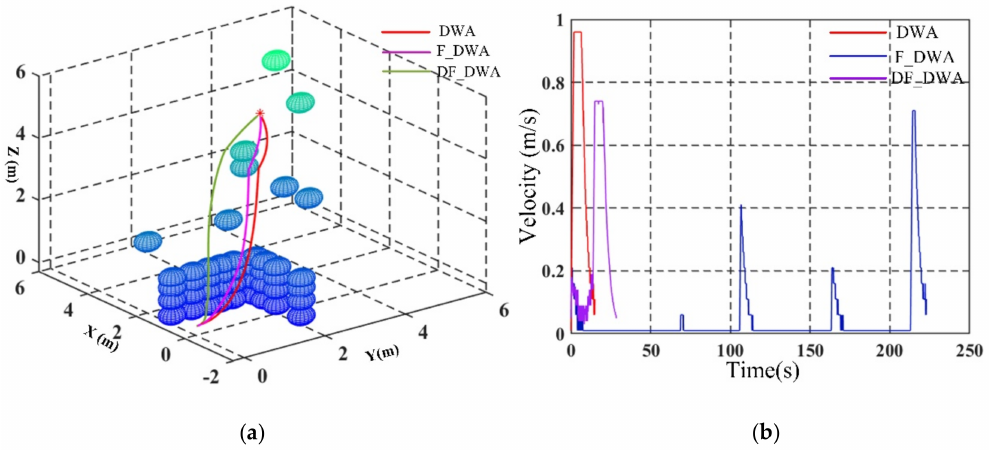
Figure 12. ( a ) planning trajectory and ( b ) velocity in the static obstacle avoidance